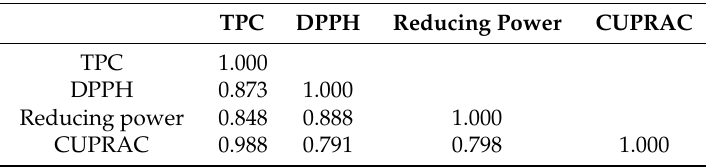
Table 2. Correlation matrix for total phenols and antioxidant capacity